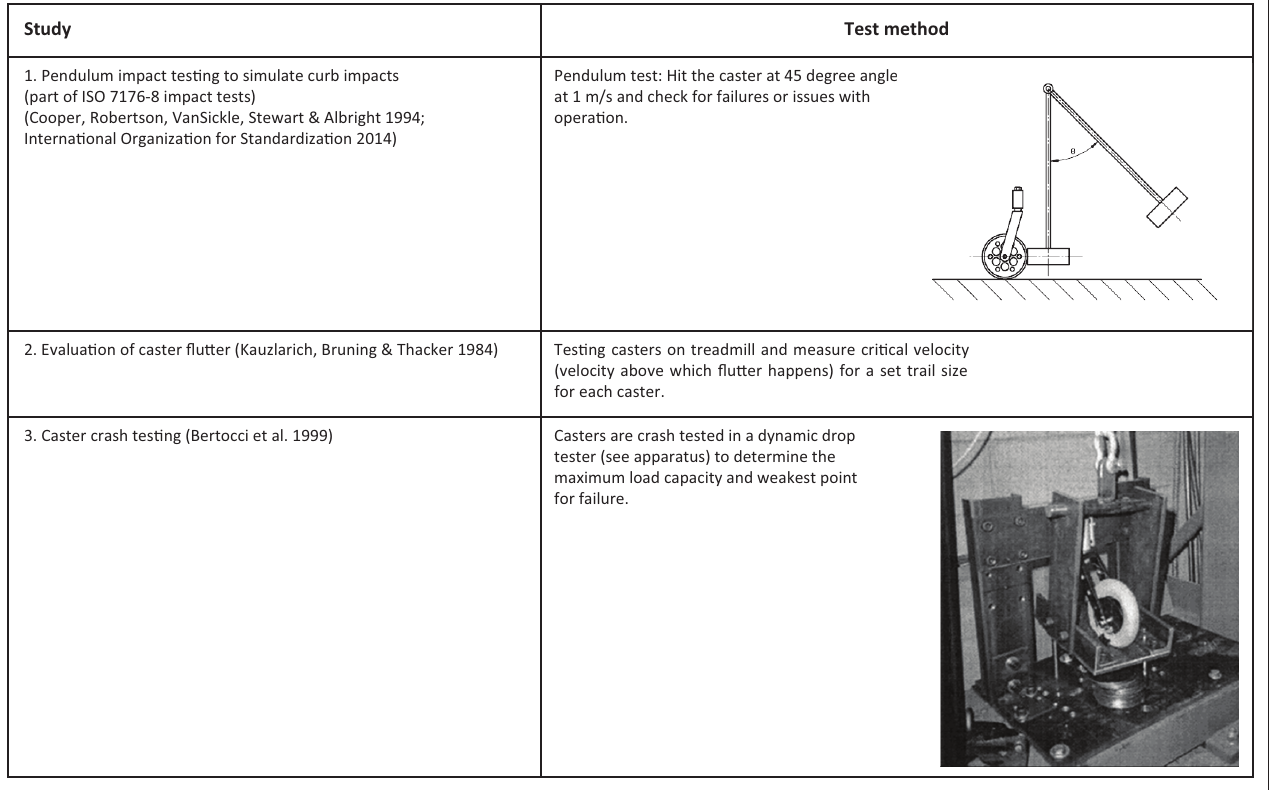
FIGURE 4: Caster test methods reported in the